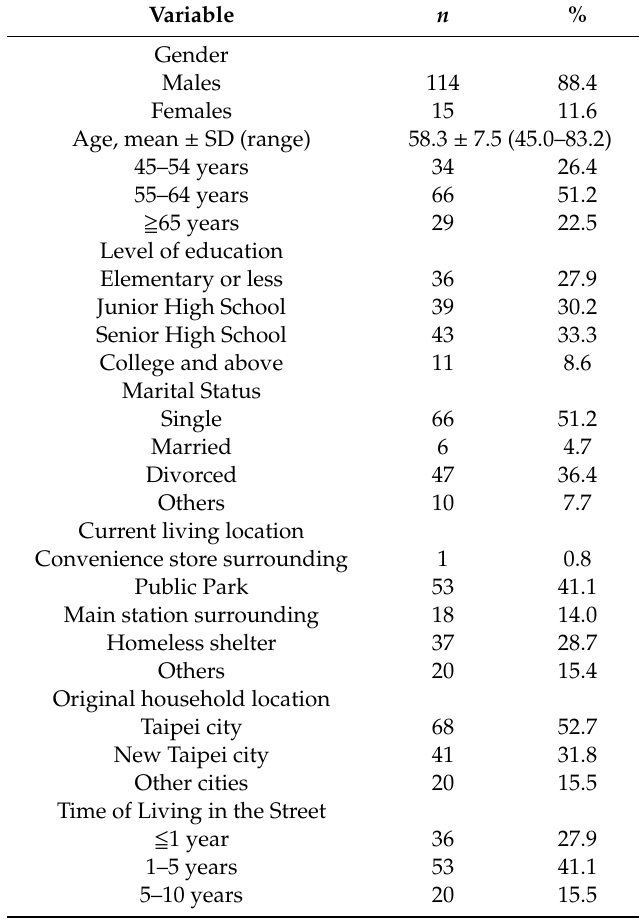
Table 1. Middle- and old-aged homeless people demographic characteristics ( n =